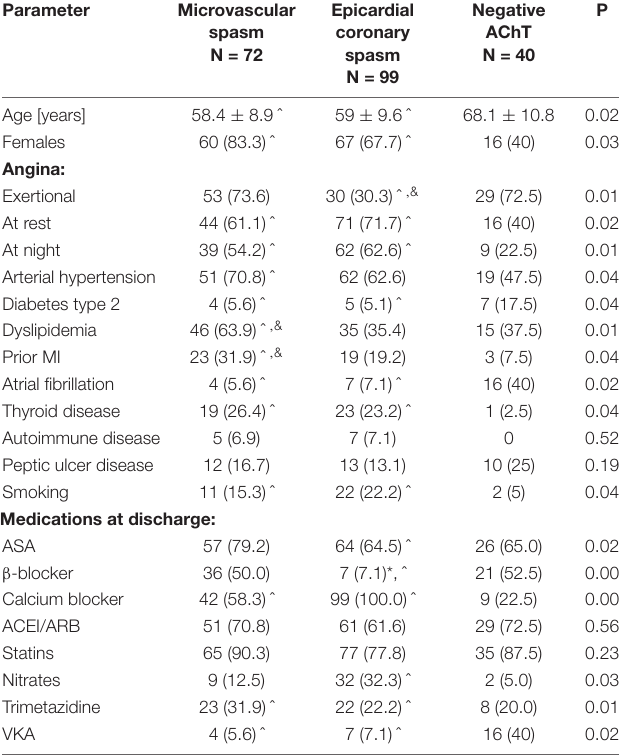
TABLE 1 | Baseline clinical characteristics.